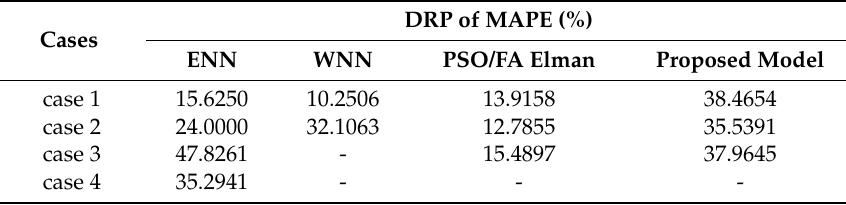
Table 13. The DRP of MAPE of the proposed model and comparison models.